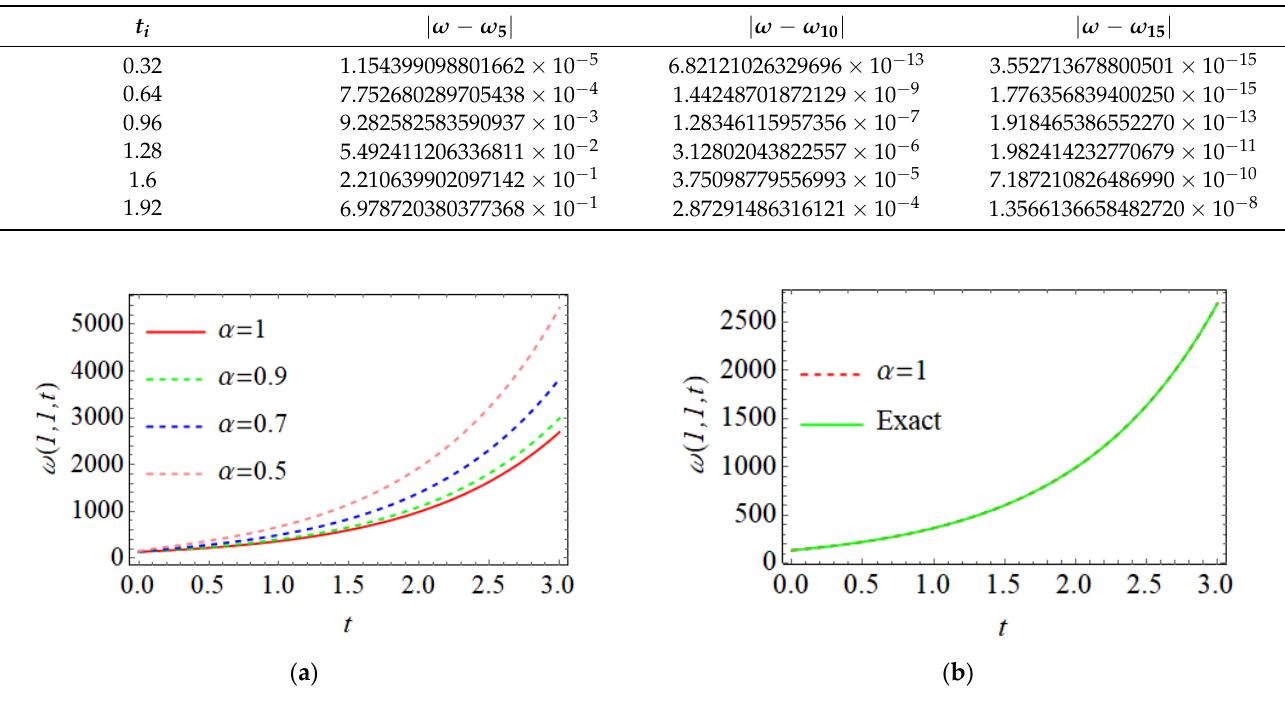
Figure 4. ( a ) Behavior of α -th curve analytical approximate solution (40) for all t ∈ [ 0,3 ] and α ∈ { 1,0.9,0.7,0.5 } , ( b ) behavior of exact solution versus the analytical approximate solution (40) for all t ∈ [ 0,3 ] .